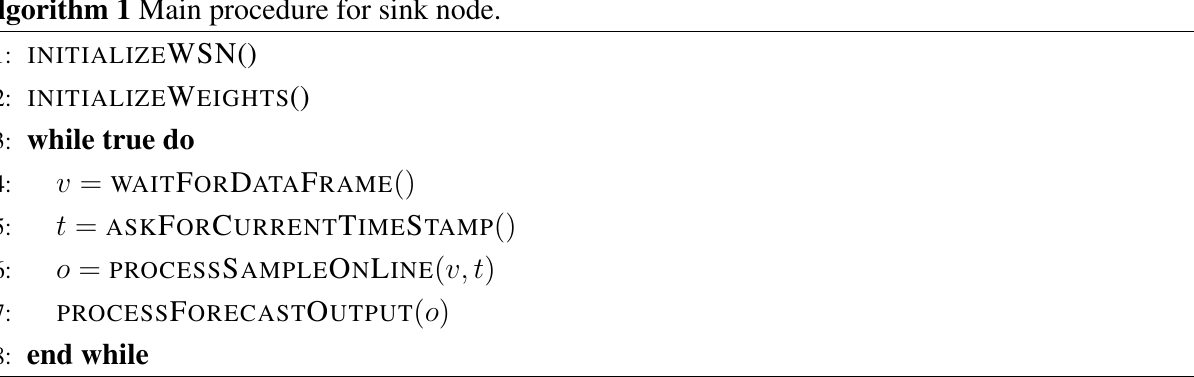
Algorithm 1 Main procedure for sink